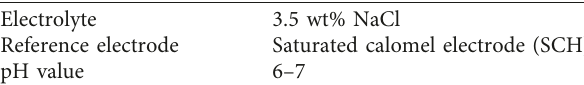
Figure 2: Macroimages of (a) powder-coated and (b) epoxy CED samples of AZ91D+0.1wt.%Ce+0.1wt.% Li alloy (5X magnification). Table 4: Conditions for polarization and impedance